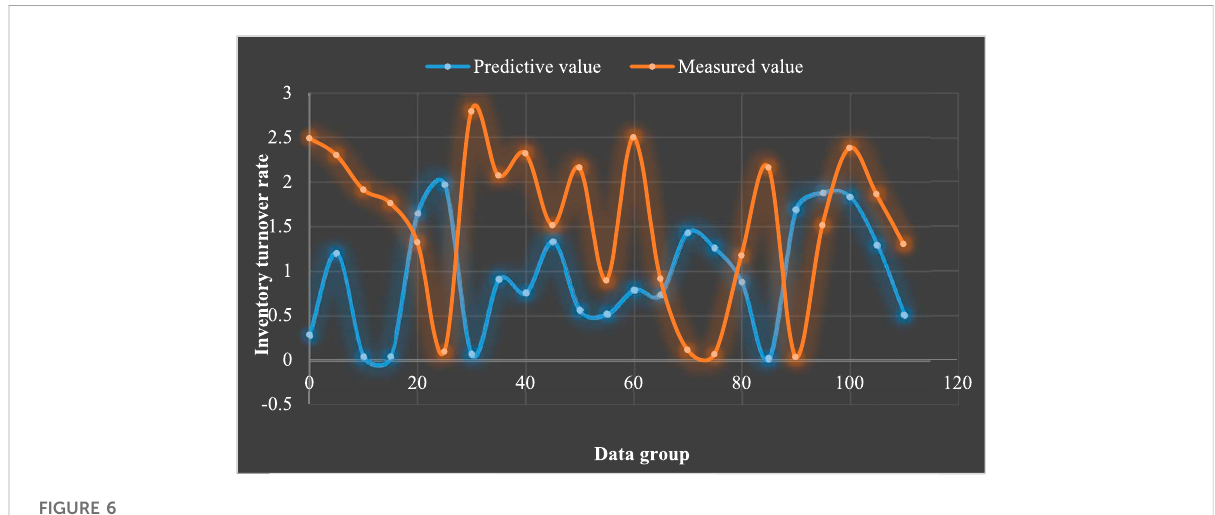
FIGURE 6 Training results of operational capability